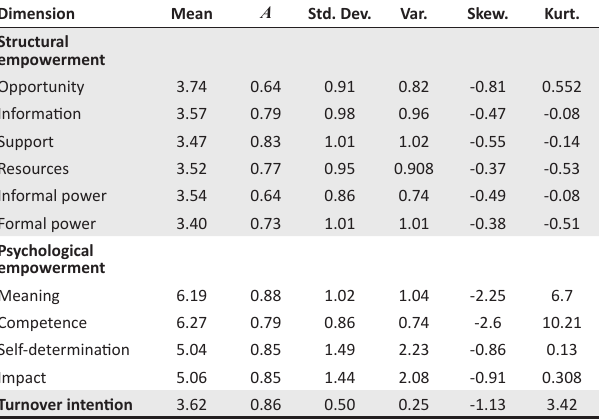
TABLE 1: Descriptive analysis for structural empowerment, psychological empowerment and turnover intention. Dimension Mean